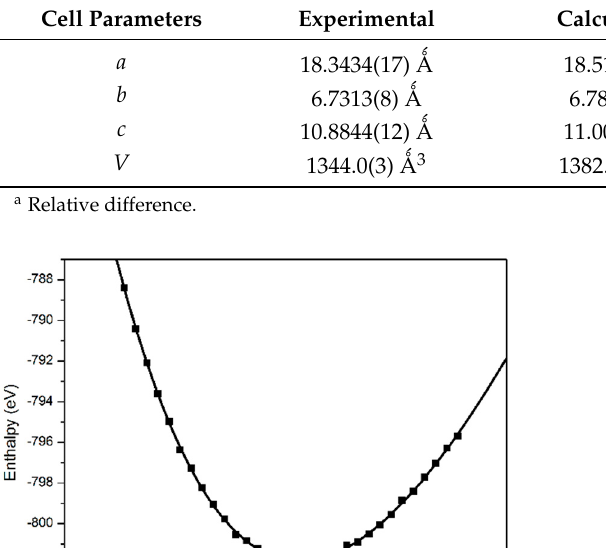
Figure 4. Total energy of Ca 7 MgSi 4 O 16 -Bre as a function of cell volume (at 0 K). Symbols represent simulated results while curve stands for the fitted E – V third-order Birch–Murnaghan equation of state ( B 0 = 90.6(4) GPa, B ′ 0 = 5.7(1), and V 0 = 1388.0(6) Å 3 ).